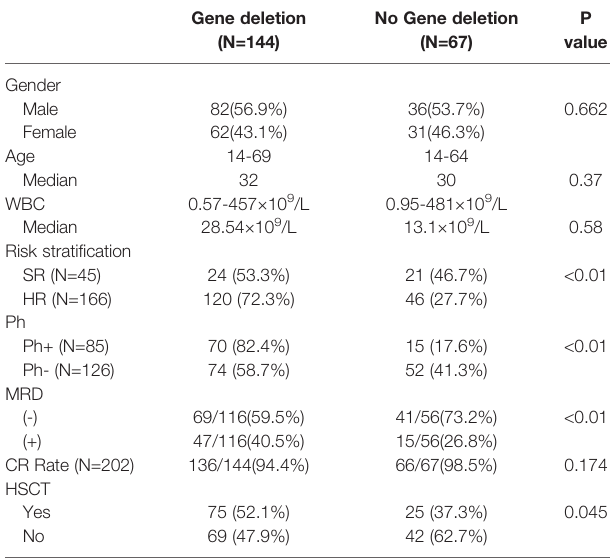
TABLE 1 | Patient characteristics grouped by gene deletion